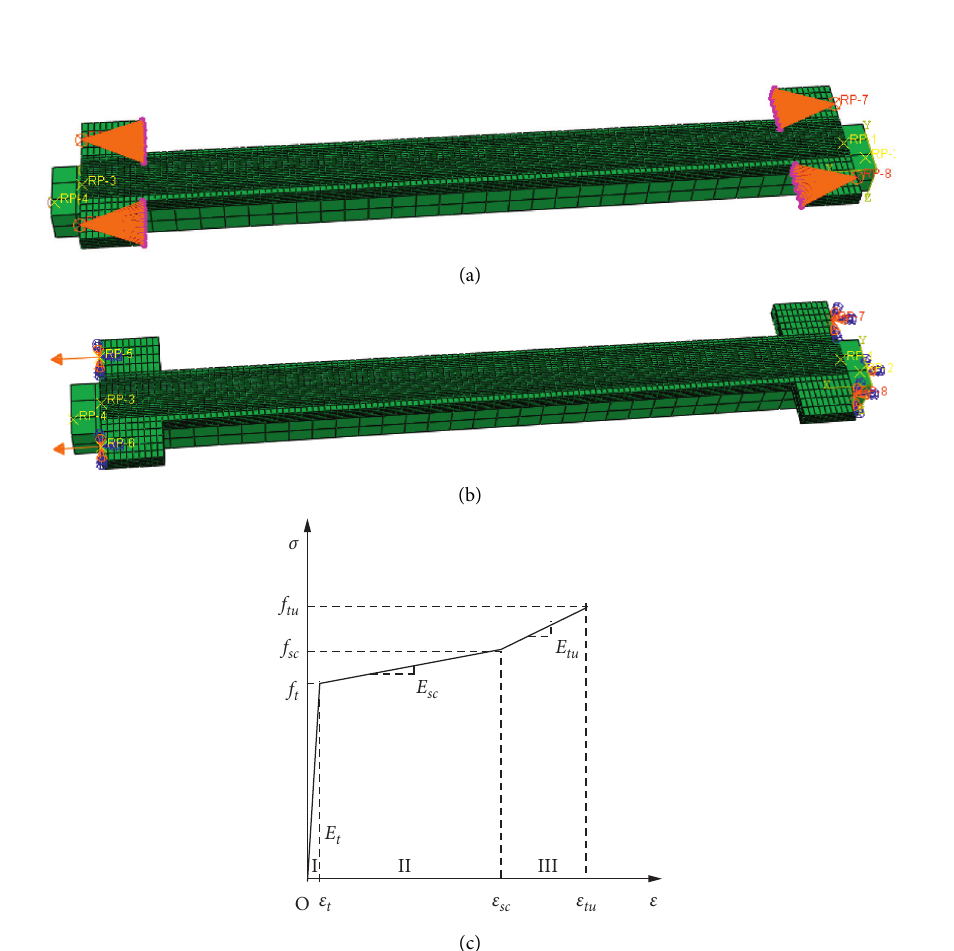
Figure 13: ABAQUS model of SHCC slab. (a) Grid division and constraints: the SHCC slab. (b) SHCC slab loading simulation. (c) Trilinear constitutive model. f t (tensile initial crack strength) � 2.0MPa, ε t (tensile initial strain) � 0.0065, f sc (corresponding stress in fracture sat- uration) � 2.35 MPa, ε sc (corresponding strain in fracture saturation) � 0.0164, f tu (extreme tensile strength) � 3.528MPa, and ε tu (extreme tensile strain) �